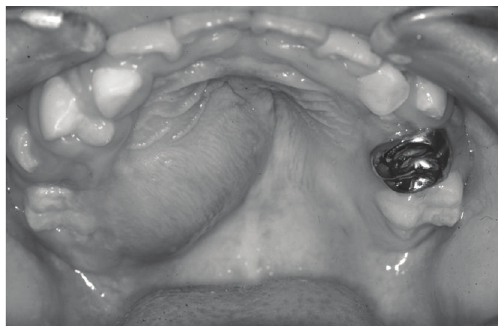
Figure 1: The tumour in the right hard palate.